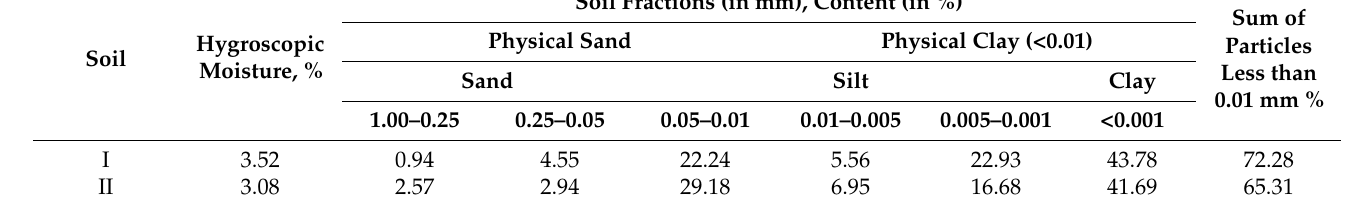
Table 2. Soils Fractions